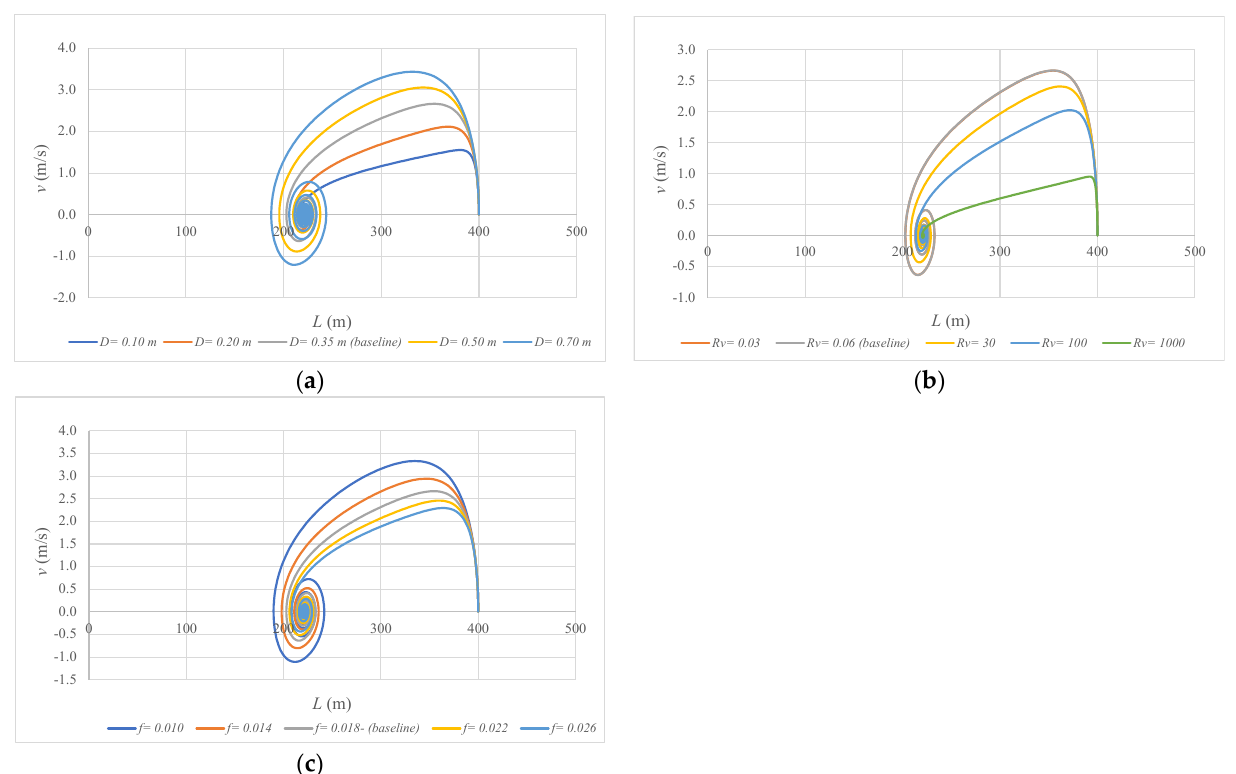
Figure 8. Sensitivity analysis for non-dependent parameters: ( a ) internal pipe diameter; ( b ) resistance coefficient; and ( c ) friction factor .